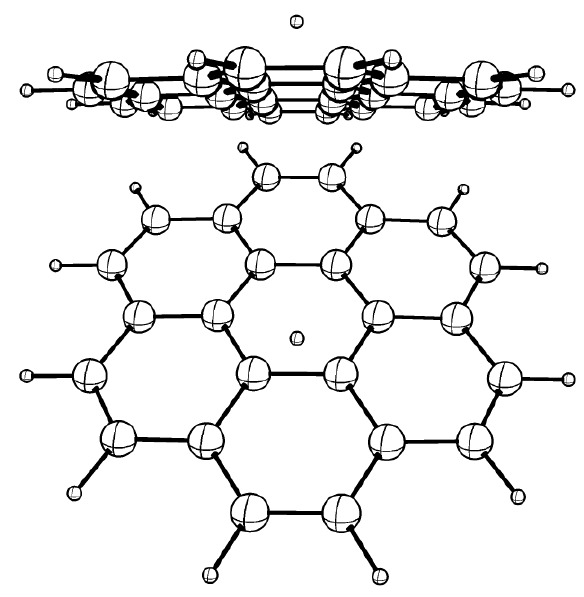
Fig. 2. The transition state of proton migration (side and top